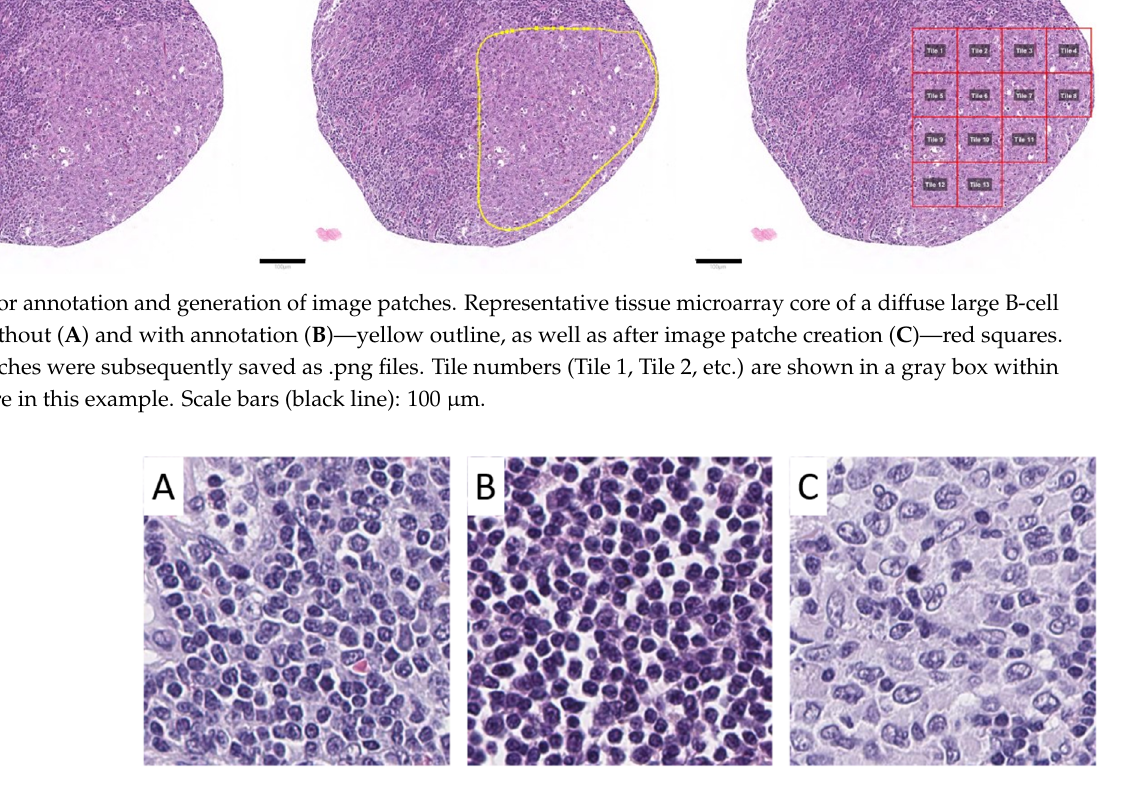
Figure 2. Examples of image patches from annotated areas. Representative image patches from control lymph nodes ( A ), small lymphocytic lymphoma/chronic lymphocytic leukemia ( B ), and diffuse large B-cell lymphoma ( C ) are shown. Magnification: each image 100 × 100 µm (395 × 395 px).